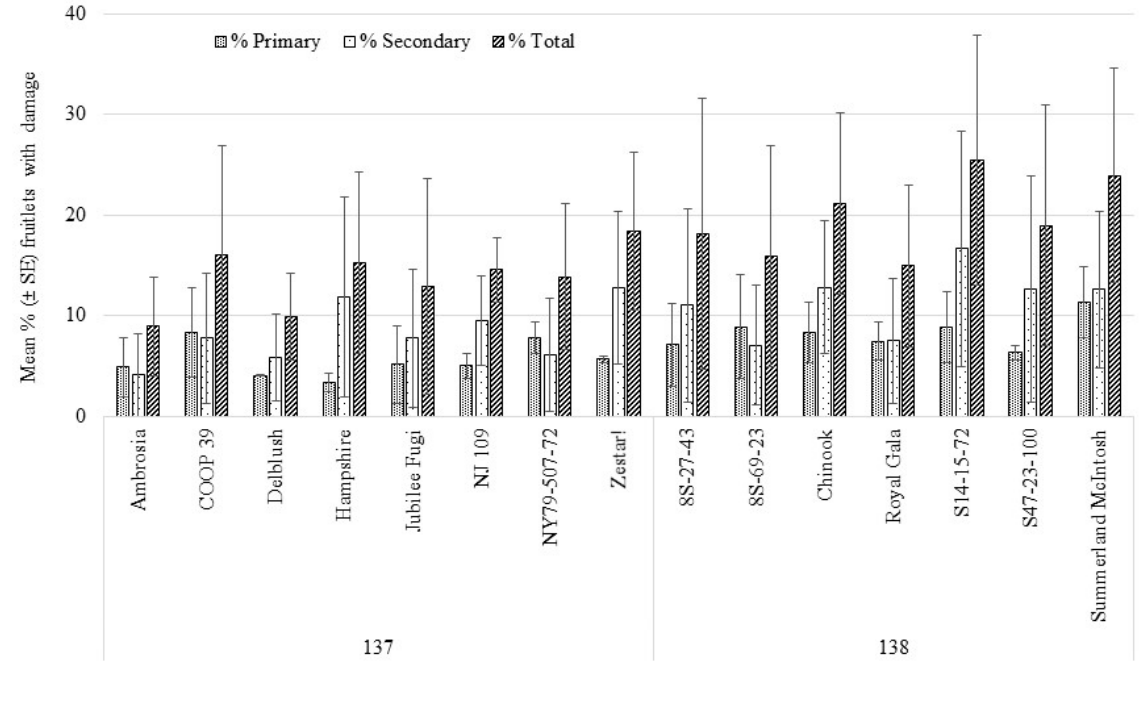
Figure 5. Mean ( ± SE) percentage of fruitlets showing primary, secondary and total damage from Hoplocampa testudinea observed in a bagged study of 15 cultivars in 2 blocks located at the Kentville Research and Development Centre in Nova Scotia over 3 years (2016, 2018 and 2019) and showing differences across cultivars. Primary: F 15,78 = 1.07, P = 0.39, Secondary: F 15,78 = 2.77, P = 0.002, Total: F 15,78 = 2.85, P = 0.001.